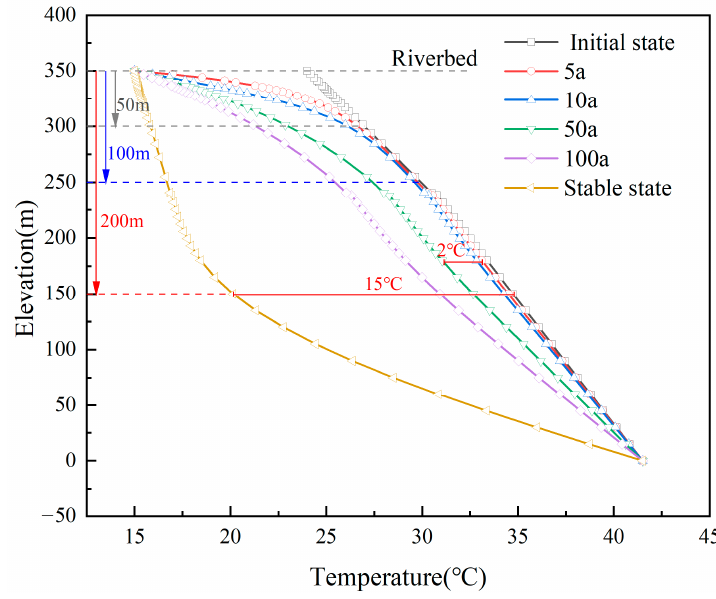
Figure 12. Temperature drop field of bedrock at different times (unit: °C).